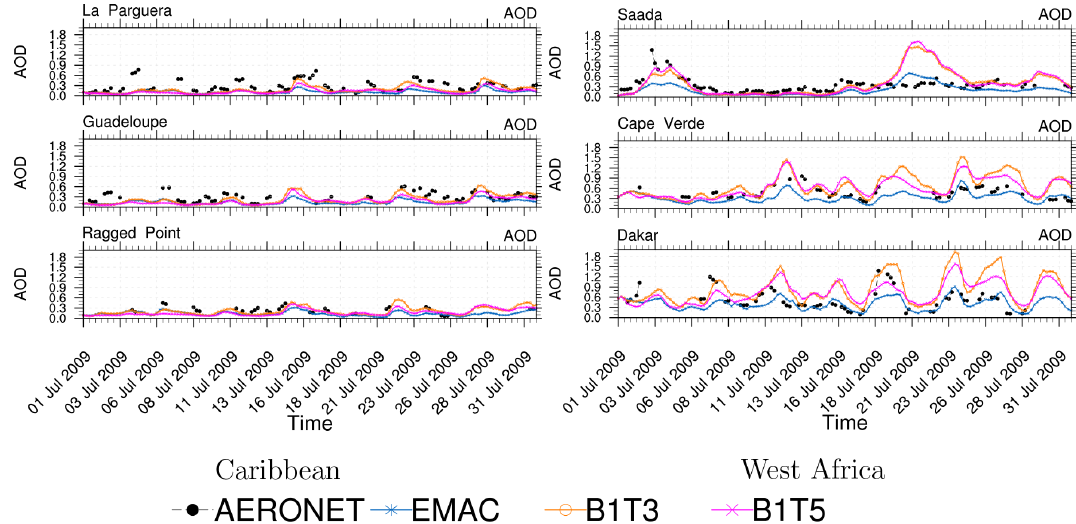
Figure 9. EMAC and AERONET AOD for western Africa (right) and the Caribbean (left) based on different convection schemes (Table